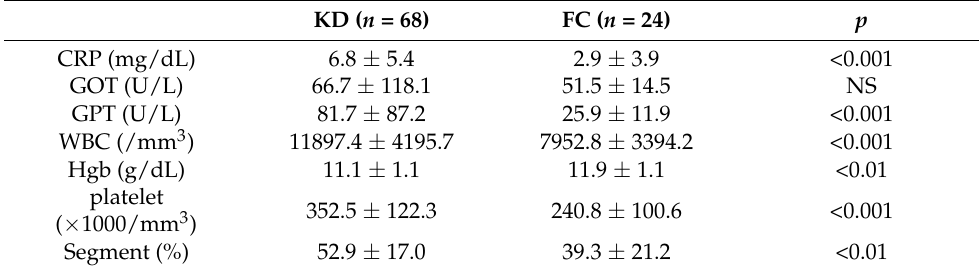
Table 2. Conventional laboratory data in the KD patients and FC